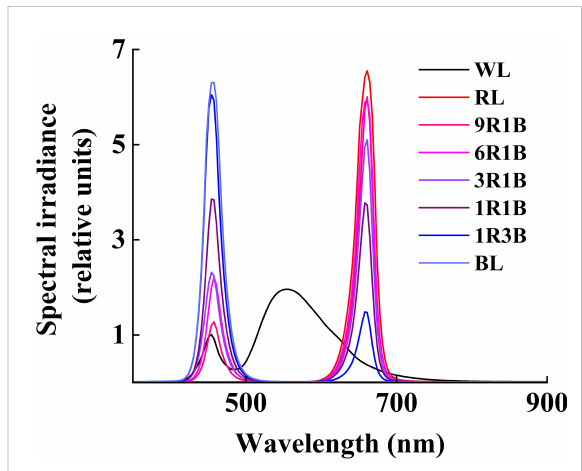
FIGURE 2 Effect of monochromatic and mixed red and blue light on plant morphology of sweet pepper seedlings at 30 day after